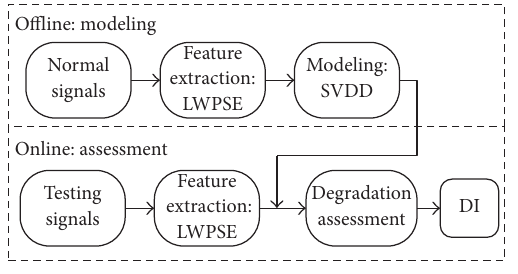
Figure 5: Procedure of performance degradation assessment.